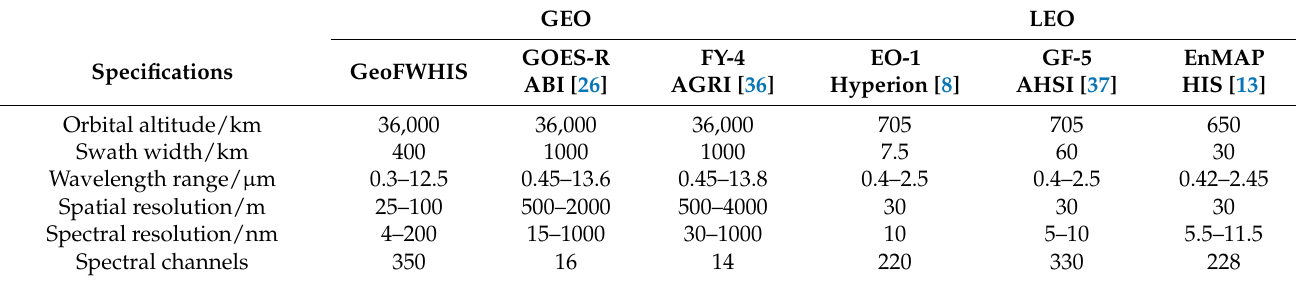
Table 2. Comparison of specifications between GeoFWHIS and some current satellite sen-